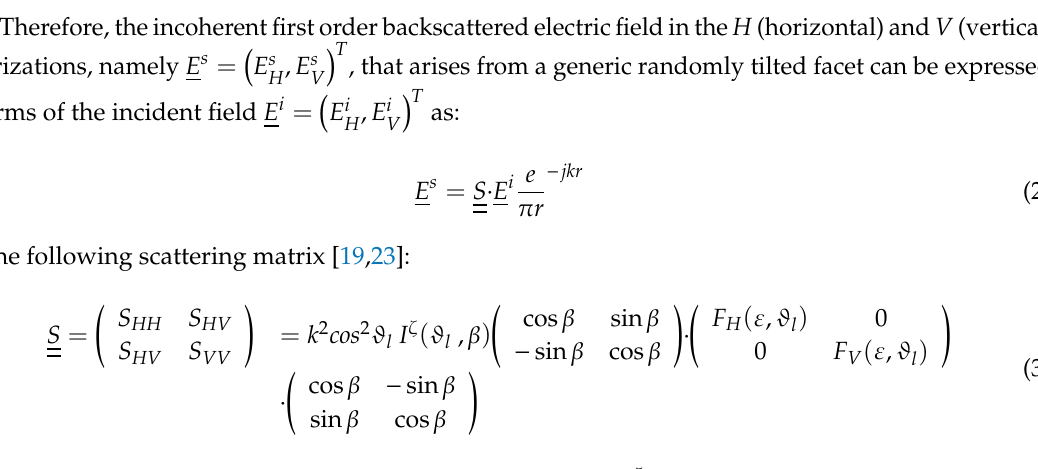
Figure 2. PTSM geometry: local rotation of the incidence plane and drift of the incidence angle.